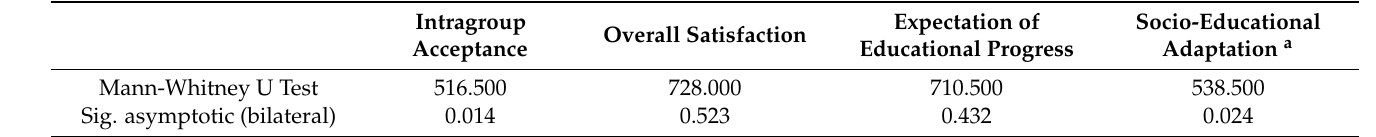
Table 5. Mann-Whitney U Test data on language facilitation interventions.